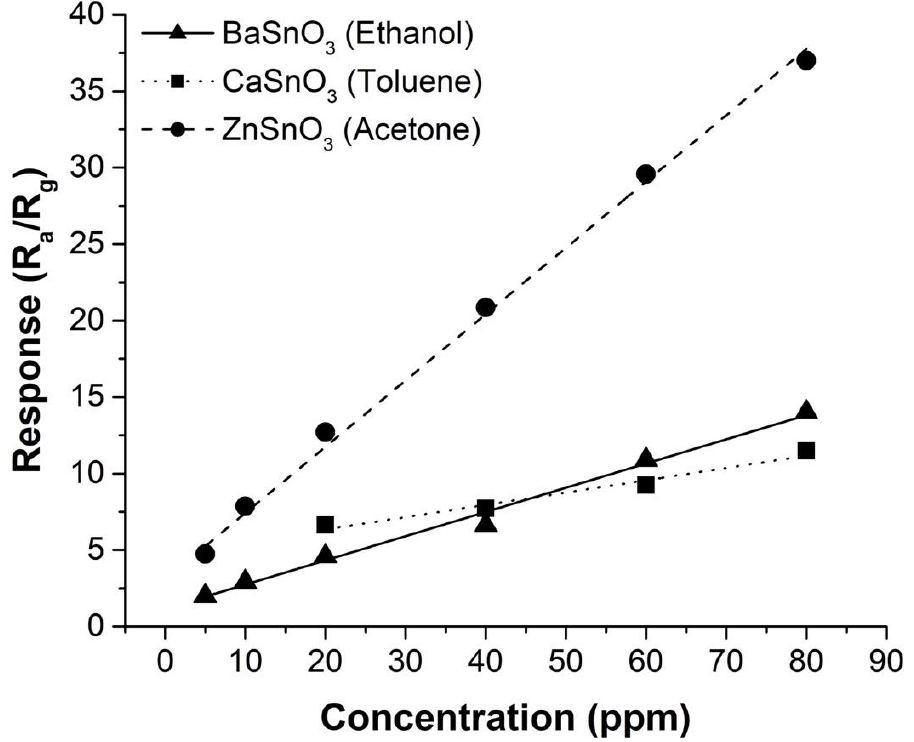
Figure 10. Fitting curve of the sensor responses of BaSnO 3, CaSnO 3 , and ZnSnO 3 to ethanol, toluene, and acetone concentrations, respectively. The gas exposure time for each concentration was 5 min.